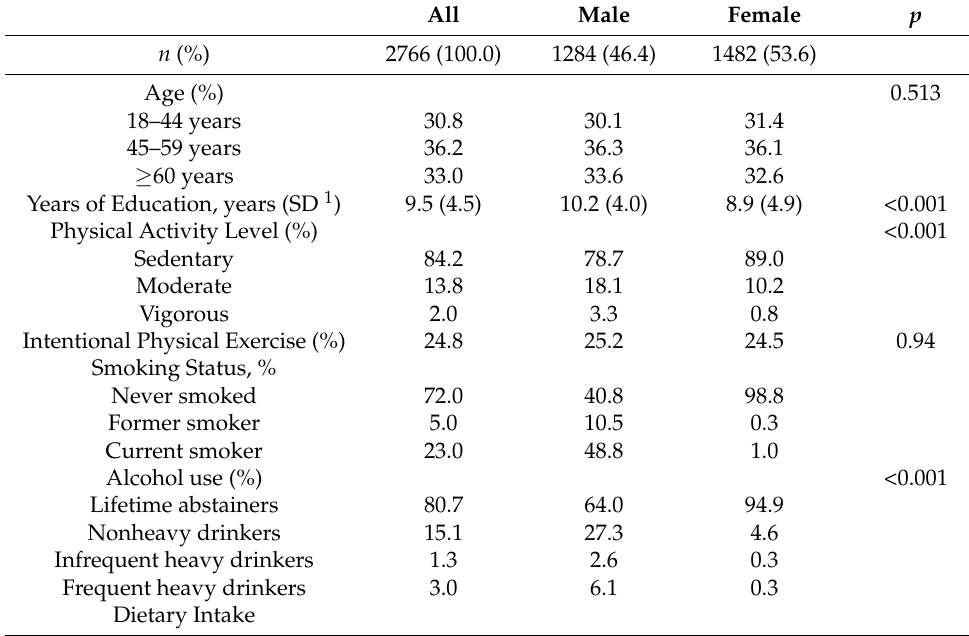
Table 1. Characteristics of the participants by